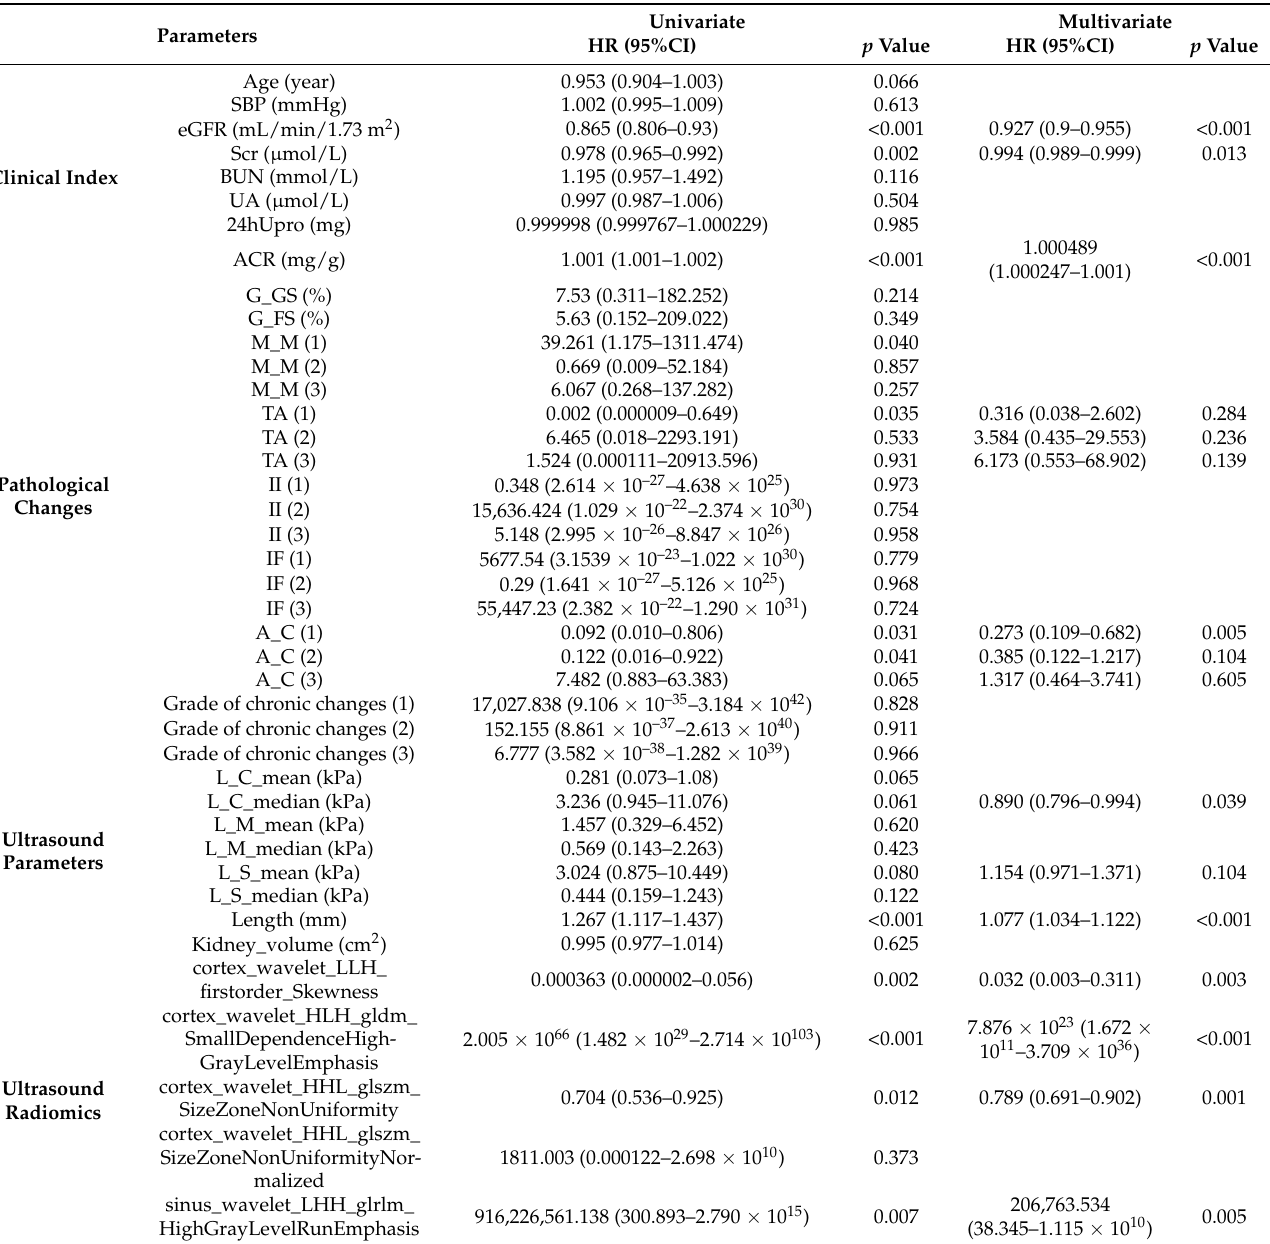
Table 2. Univariate and multivariate Cox regression for CKD